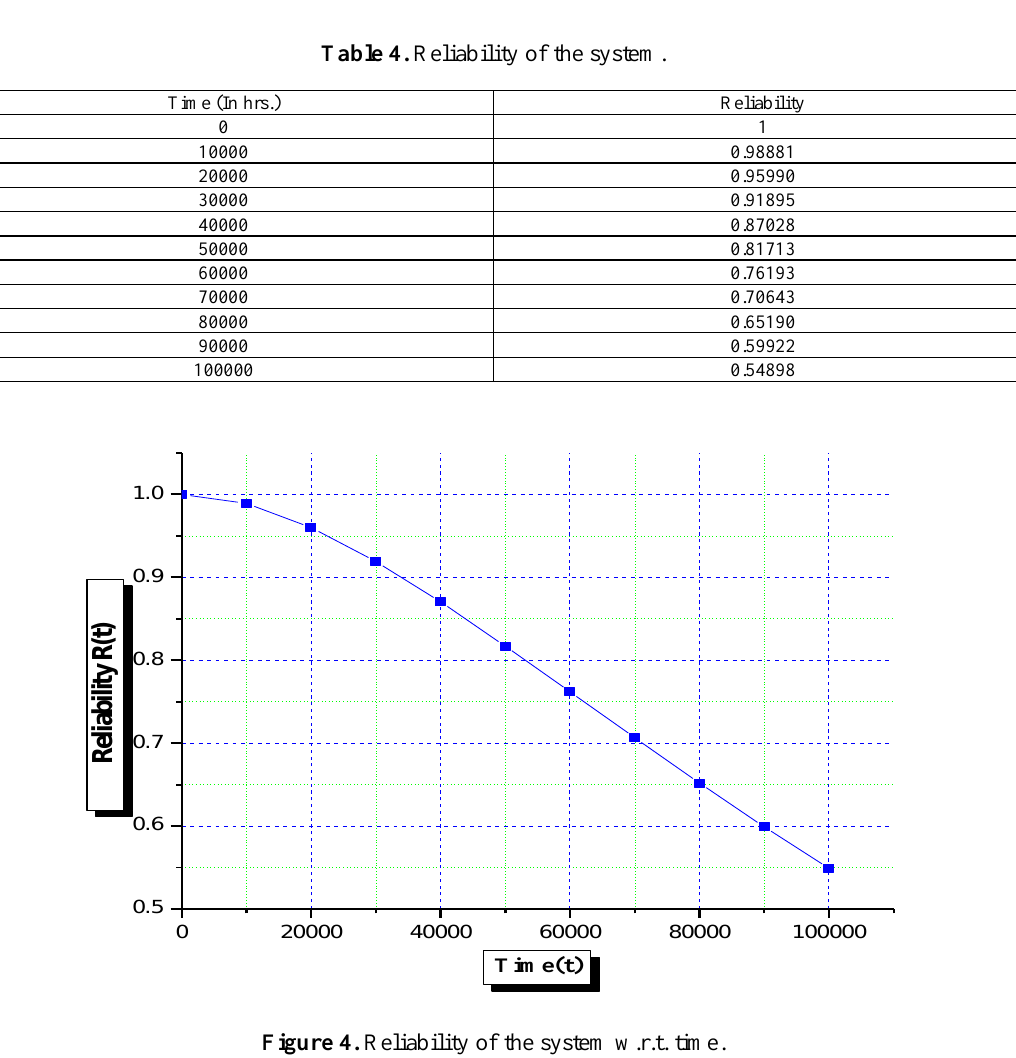
Figure 4. Reliability of the system w.r.t.